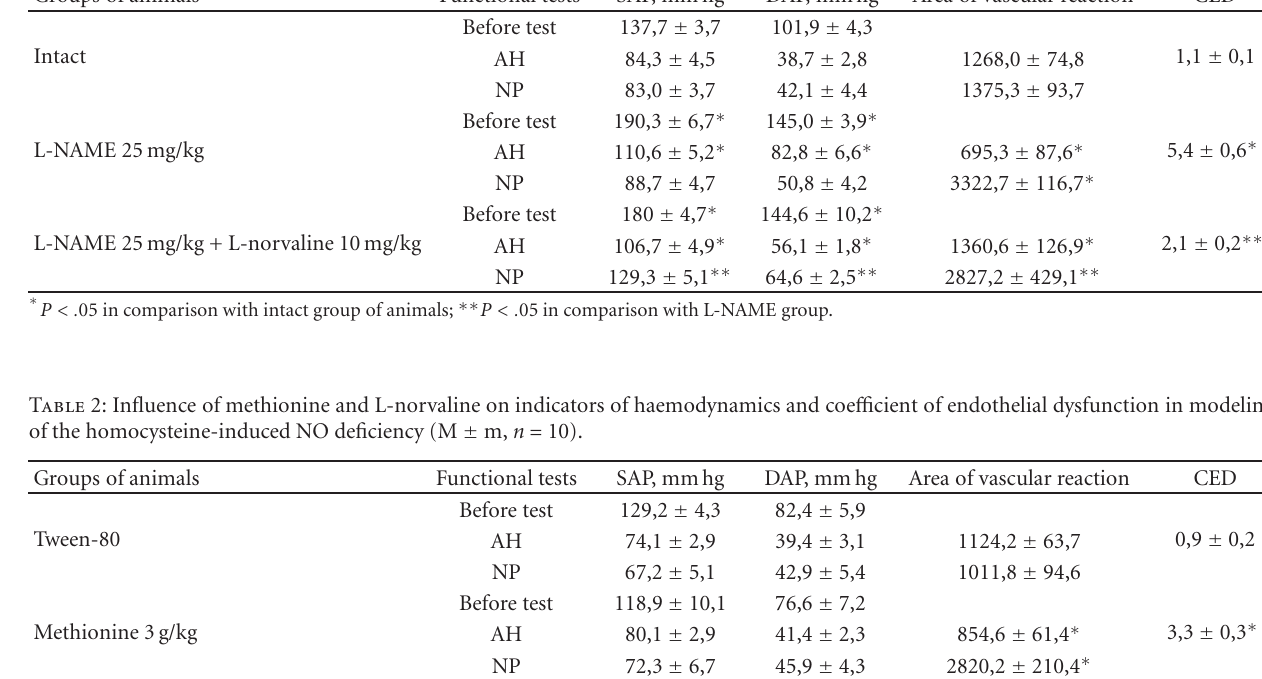
Table 1: Dynamics of blood pressure indicators on modeling of NO deficiency and its correction with L-norvaline (M ± m, n = 10). Groups of animals